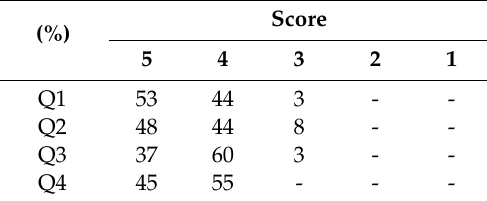
Table 3. Results of the questionnaire.